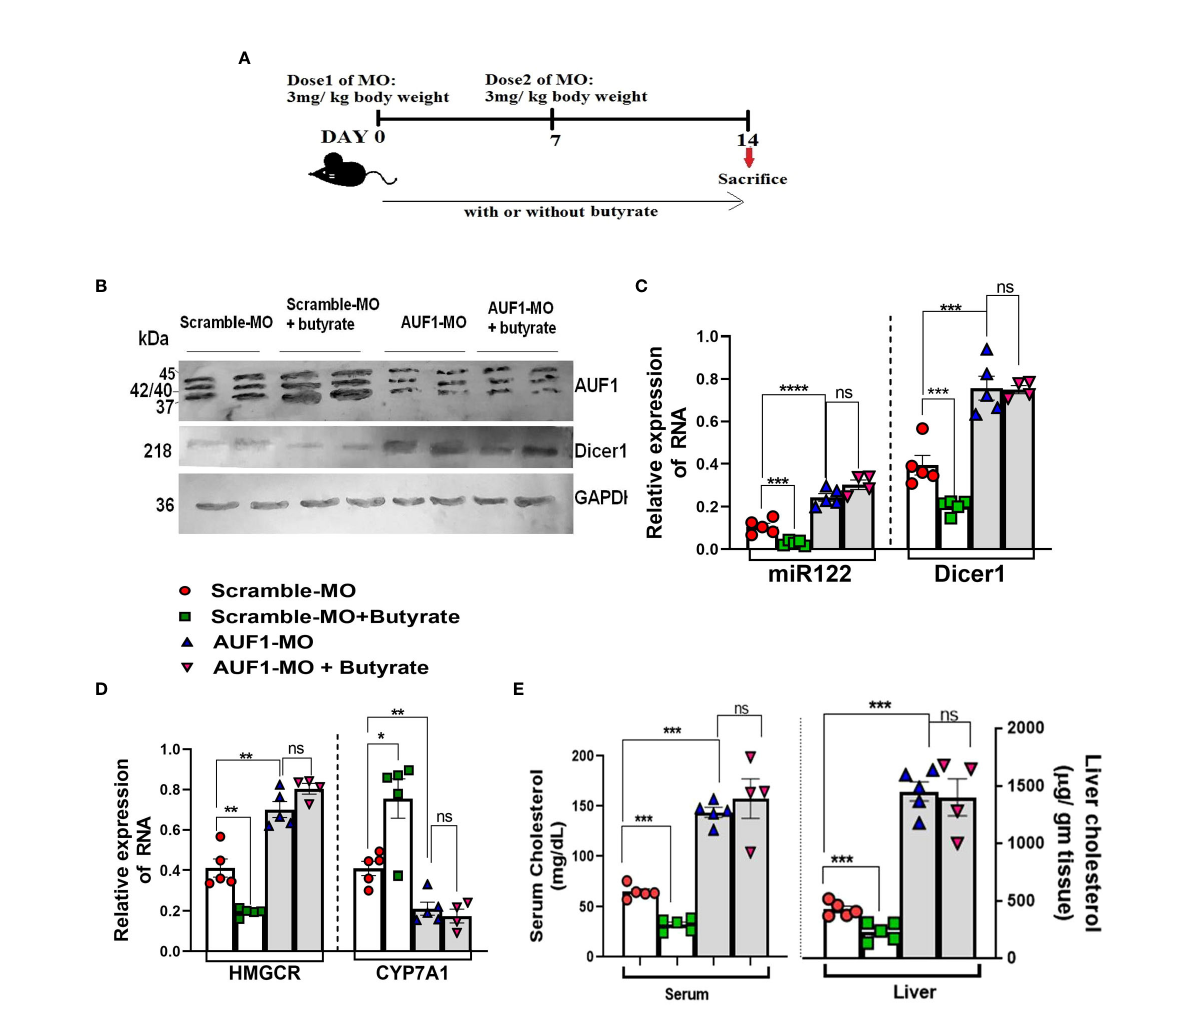
FIGURE 8 In vivo knockdown of AUF1 increases cholesterol synthesis by exploiting the AUF1 – Dicer1 – miR122 – cholesterol pathway regardless of butyrate treatment. Female mice (20 in number) were divided randomly into four groups: AUF1-MO-injected mice (AUF1-MO mice), AUF1-MO-injected mice fed with butyrate supplement (butyrate AUF1 MO mice), scramble-MO-injected mice (scramble MO mice), and scramble-MO-injected mice fed with butyrate supplement (butyrate scramble MO mice); the scheme was shown schematically (A) . Western blots to determine hepatic expression of AUF1 and Dicer1 (B) . GAPDH was used as control. AP-conjugated secondary antibodies were used in Western blot. Expression of hepatic miR122 and Dicer1 determined by qPCR (C) . Hepatic expression of cholesterol metabolizing enzymes: HMGCR and Cyp7A1 determined by qPCR (D) . Serum and liver cholesterol were measured and expressed in mg/dl and µg/g tissue, respectively (E) . N = 5/group; data are presented as mean ±SE. The experiment was repeated twice. **** represents p < 0.0001, ***represents, ** represents p<0.01, * represents p<0.05 p < 0.001, and ns represents not signi fi